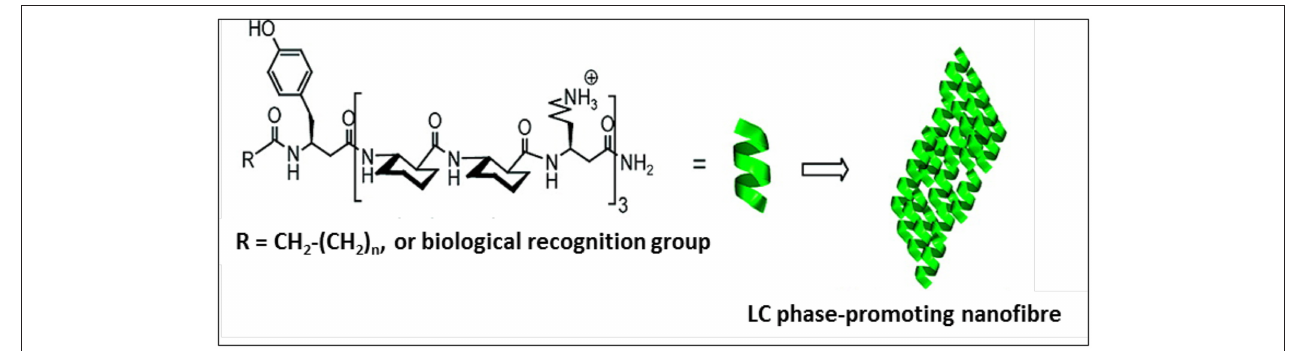
FIGURE 5 | Self-assembled lyotropic liquid crystals with a minimum of three repeats of the ACHC-ACHC- β 3 -Lys triad. Biological recognition group (biotin or the tripeptide RGD) was incorporated at R. Adapted with permission from Pomerantz et al. (2011) Copyright 2011 American Chemical Society.